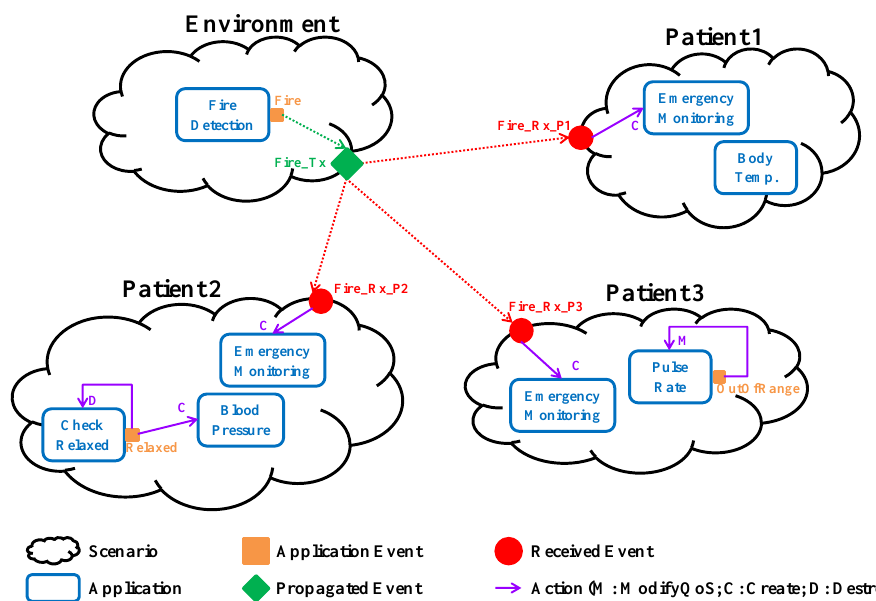
Figure 1. Graphical representation of the user view specification related to a nursing home with three patients.